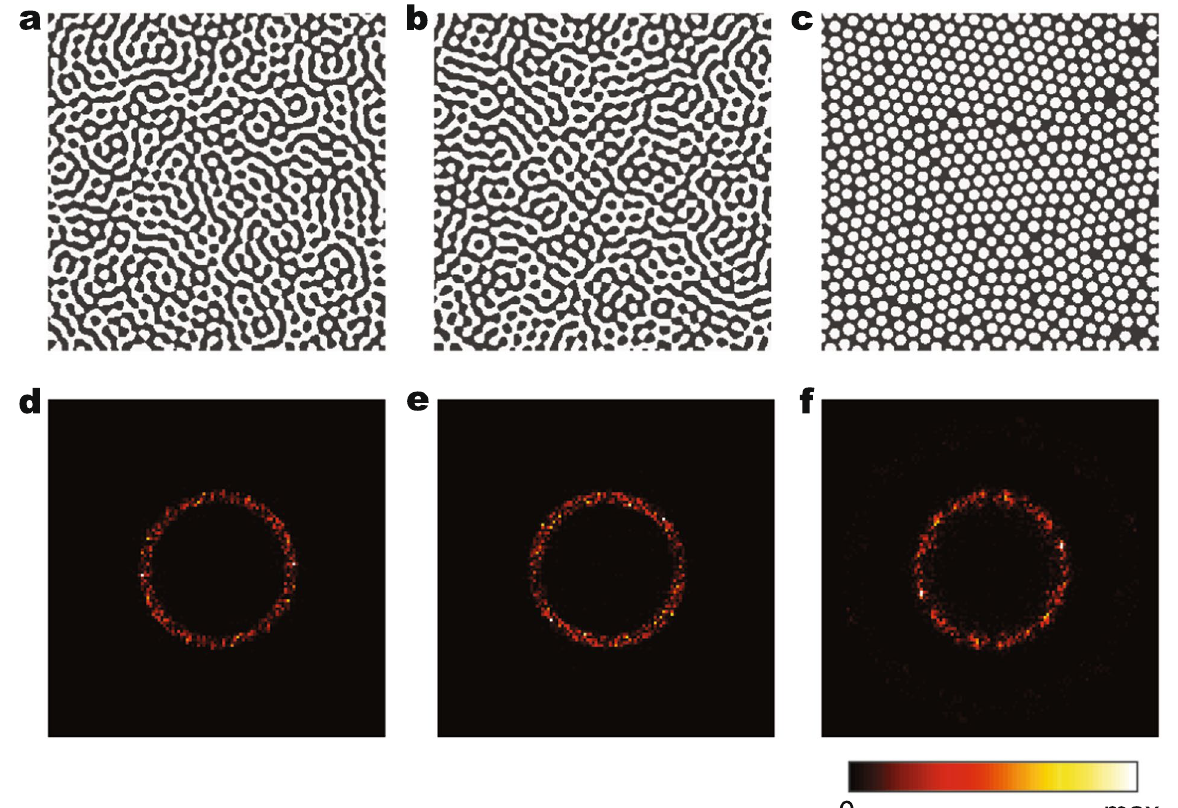
Figure 1. One-to-multiple mapping from Fourier space characterization to real-space geometries of non- deterministic quasi-random structures. ( a , b ) Two quasi-random structures with channel-type morphology that can be obtained from spinodal decomposition process ( c ) A disk-type quasi-random structure that can be obtained from nucleation based phase separation process. ( d – f ) The Fourier spectra of the structures in ( a – c ),